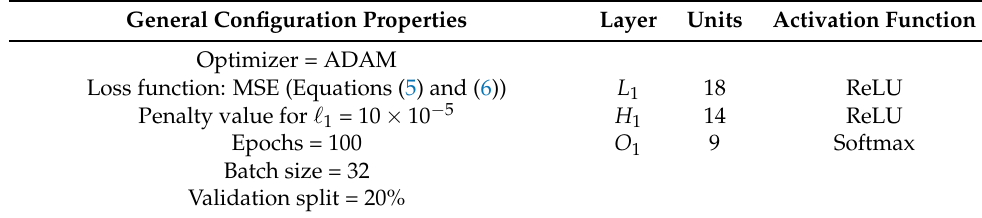
Table 4. Settings and parameters for SAE